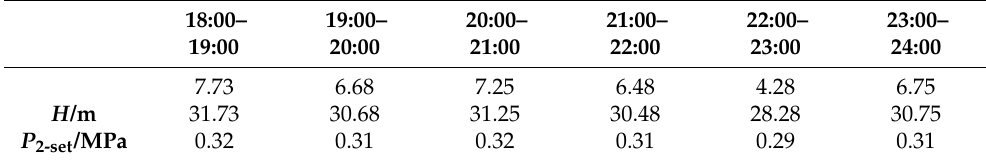
Table 8. P 2-set (MPa) during 18:00–24:00.